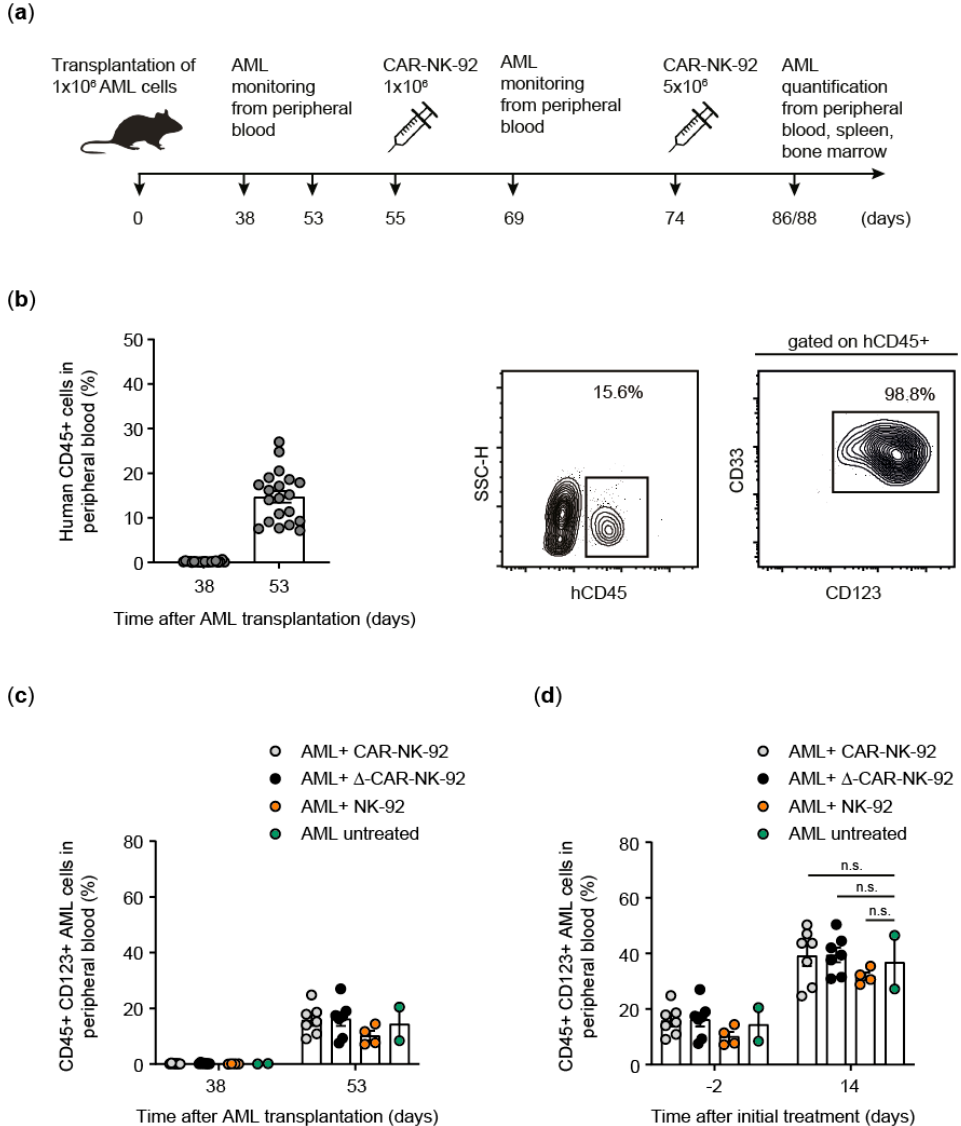
Figure 3. Establishment of an AML-PDX mouse model for anti-CD123-CAR-NK-92 treatment. ( a ) Experimental outline of in vivo AML-PDX engraftment and CAR-NK-92/effector cell treatment. ( b ) AML engraftment in peripheral blood at 38 and 53 days after transplantation. Representative flow cytometric analyses indicating primary human AML cells (hCD45 + ) and their stable phenotype (hCD45 + CD33 + CD123 + ) are shown. ( c ) Prior to treatment, AML-PDX mice were separated into four groups (untreated ( n = 2), or treated with 1 × 10 6 unmodified NK-92 cells ( n = 4), treated with 1 × 10 6 ∆ -CAR-NK-92 cells ( n = 7) or 1 × 10 6 full-length CAR-NK-92 cells ( n = 7)), each containing mice with similar AML levels as determined by flow cytometric analyses of peripheral blood (hCD45 + CD123 + ). ( d ) After initial treatment, AML progression occurred in all groups as flow cytometric analyses showed an approximately two-fold increase in peripheral blood hCD45 + CD123 + AML cells. Data are shown as mean ± standard error of mean (SEM). The unpaired t -test was used to assess differences between groups and p values ≥ 0.05 were considered statistically non-significant (n.s.).